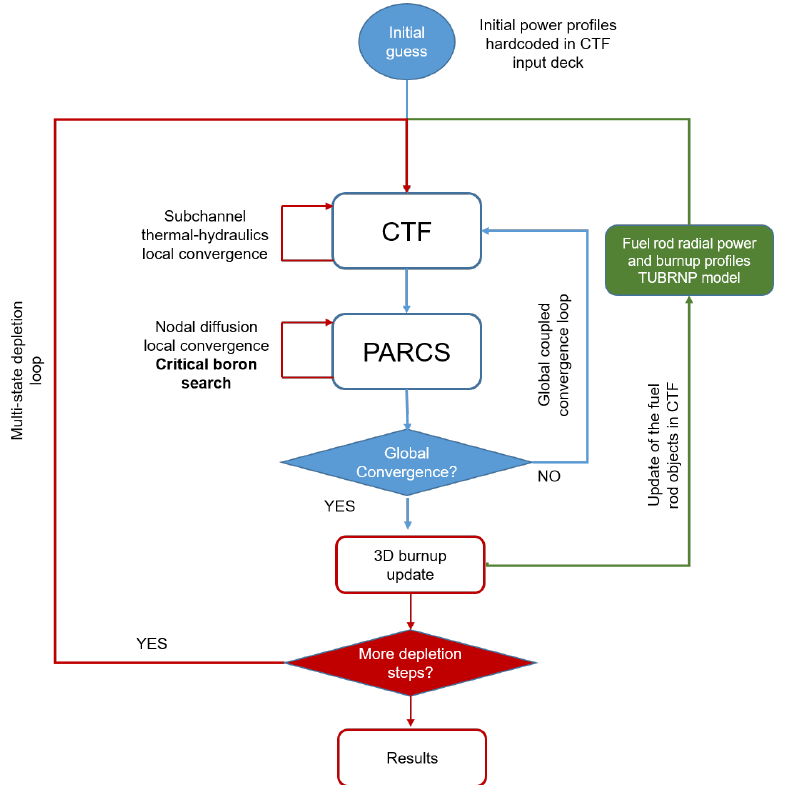
Figure 7. Scheme of the coupled code convergence during depletion